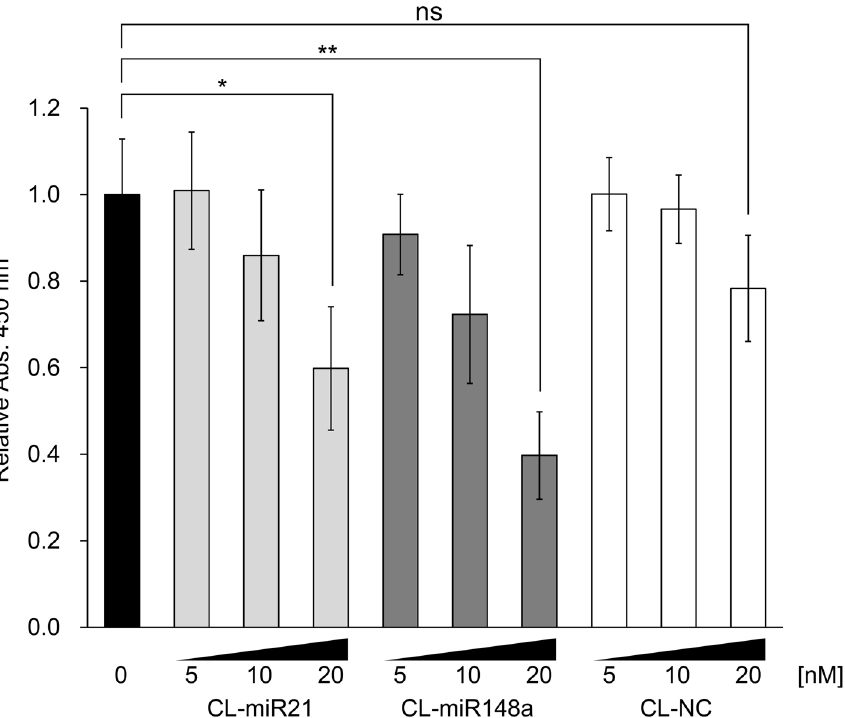
Figure 3. Relative number of MCF-7 cells transfected with CL-AMOs (CL-miR21, CL-miR148a, or CL-NC) 6 days after transfection. AMO concentrations varied from 0 to 20 nM, as labeled below the x-axis. Error bars represent SD. “ns” indicates insignificant; * p < 0.05; ** p <